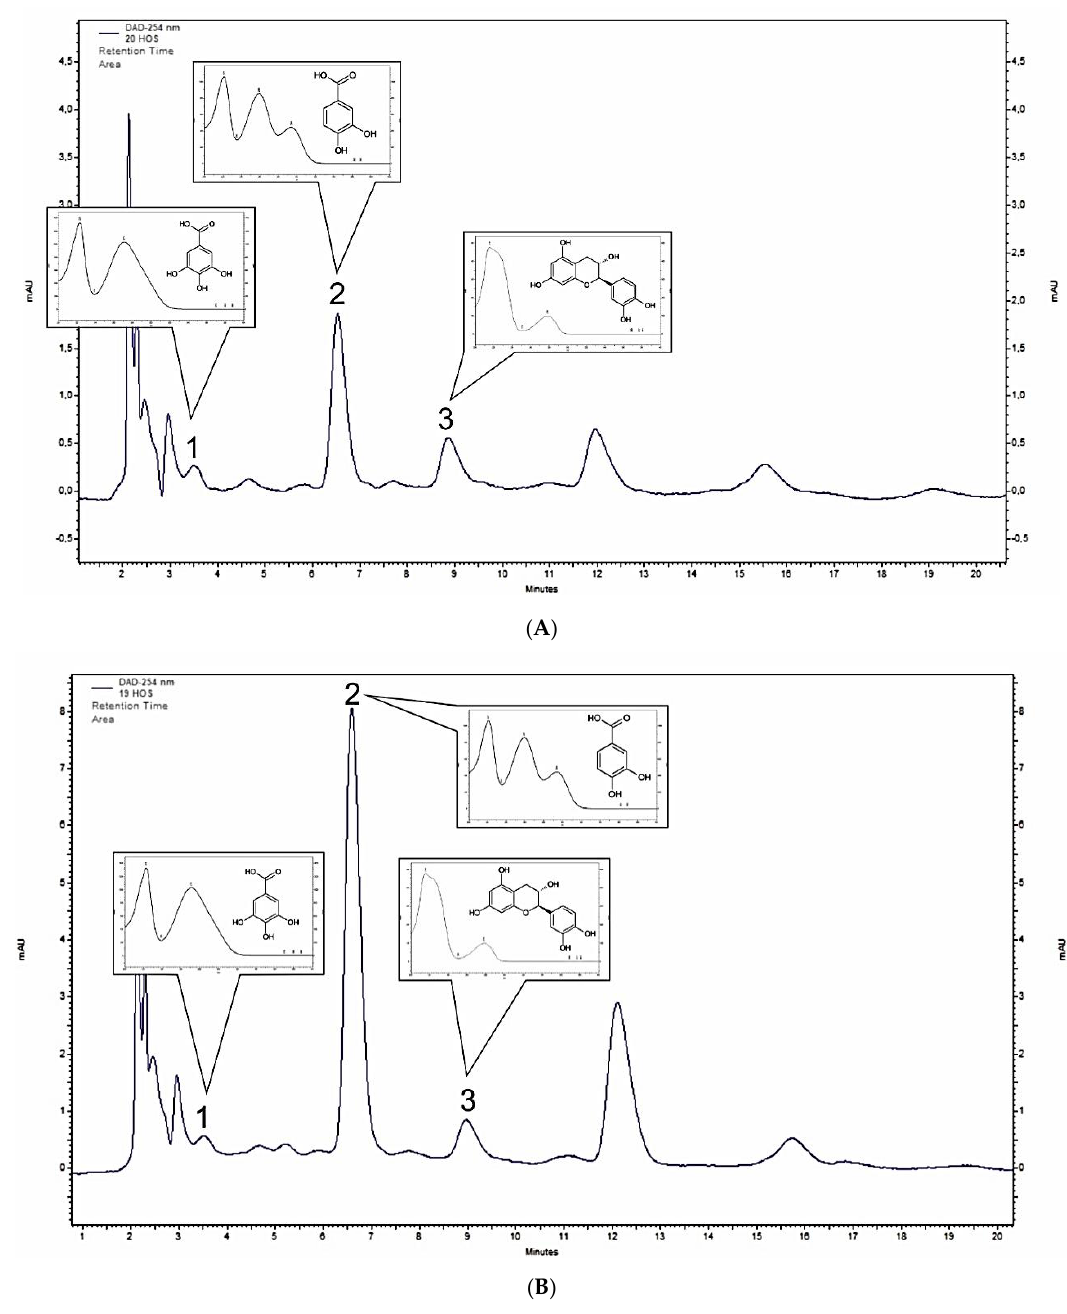
Figure 2. The chromatographic separation of methanolic bark extracts of Malus baccata ( A ) and Malus toringoides ( B ) by the high-performance liquid chromatography with a diode-array detector (HPLC-